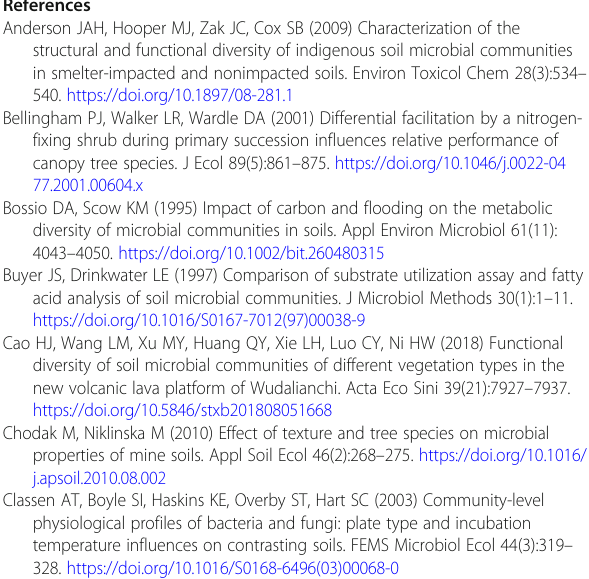
Additional file 1: Supplement Table 1. Loading factors of the principal components of the 31 individual carbon